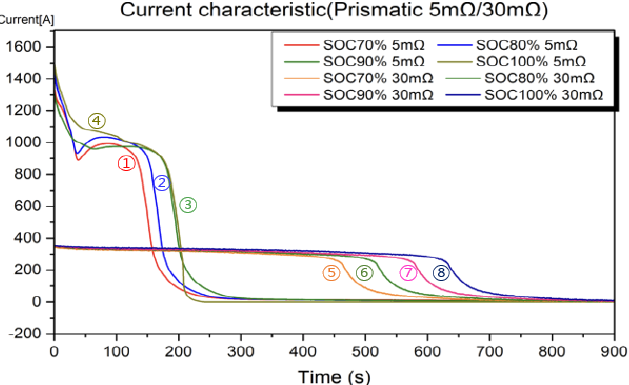
Figure 7. Current status of prismatic cells during test with SOC and short-circuit resistance.